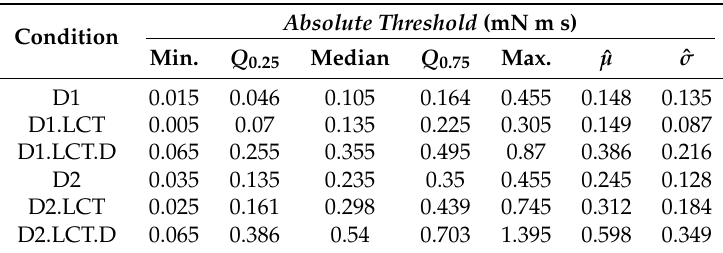
Table 2. Absolute detection thresholds for damping in different conditions with knob diameter (D1/D2), distraction (LCT/-), and detent (D/-). Values are given in